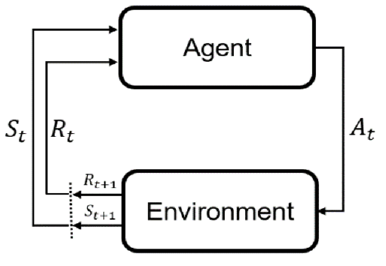
Figure 1. Markov decision process.